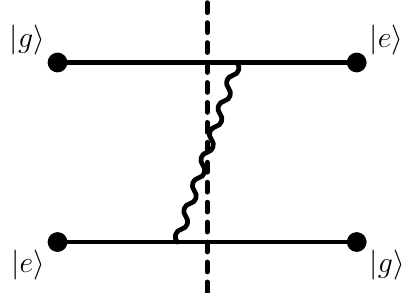
Figure 2. When the resonant virtual exchange photon becomes on-shell (a real photon), a decay process is being described. By the Cutkosky rules [50], this is denoted by a vertical dashed line which cuts the diagram. Only one of the diagrams in Figure 1 contributes to the imaginary part. The internal state of the diagram, which is cut open, has both atoms in the ground state and the photon becoming